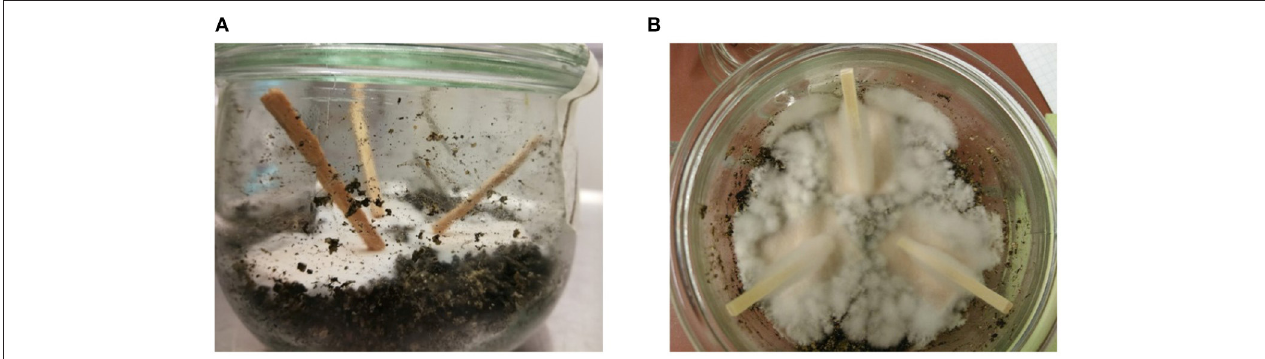
FIGURE 2 | Sample setup for directional growth of R. placenta , inspired by Zhang et al. (2016). (A) Kurile larch before degradation. (B) Norway spruce with hyphal front after degradation.